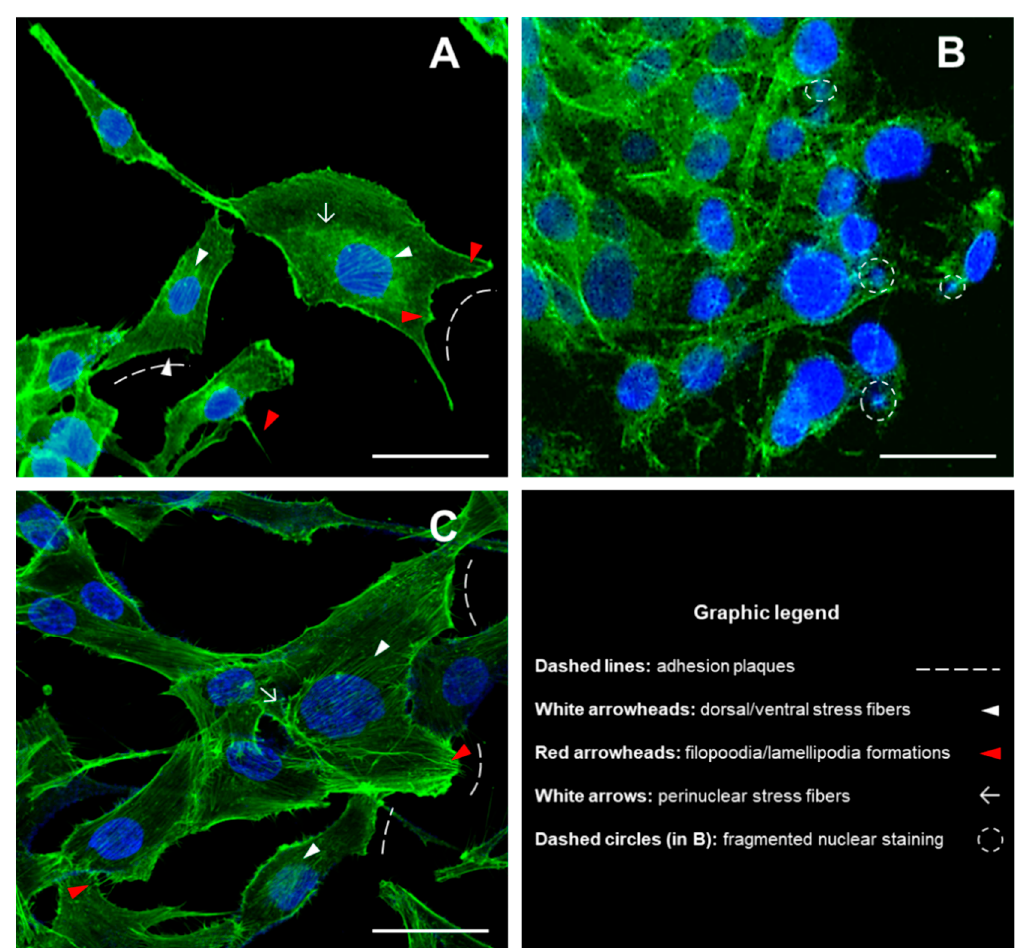
Figure 1. Morphological analysis of cytoskeleton and nuclei in MG63 cells grown for 48 h in the presence of DM nanoparticles and DM/n-HA (2:1) nanocomposites. Fluorescence imaging was performed by using Phalloidin-FITC (green fluorescence) and DAPI (blue) for staining cytoskeleton and nuclei, respectively. The morphology of cytoskeletal structures and nuclear shape has been detected in untreated control cells ( A ), DM-treated cells ( B ) and DM/n-HA-treated cells ( C ). Image capture was performed by a Zeiss LSM 710 confocal microscopy system, equipped with the ZEN 2009 software (LSM 710 suite) [scale bar: 50 µm; magnif. 40X].